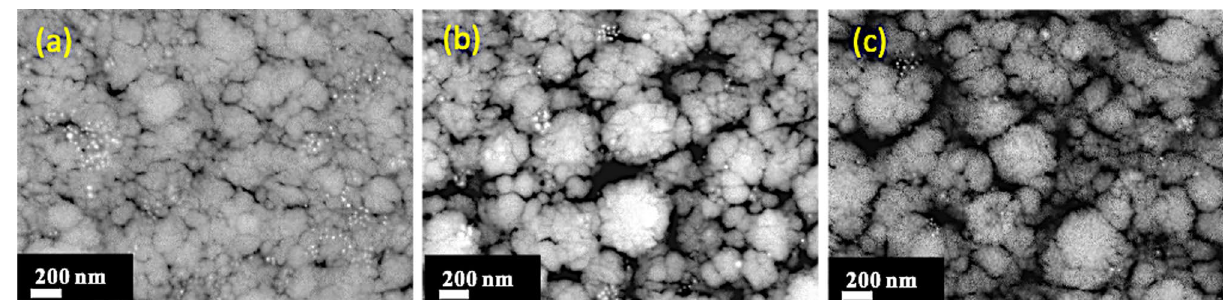
Figure 6. Backscattered electron micrographs of TiO 2 /Au-np nanocomposite films synthesized with increasing the matrix deposition rate via the current intensity applied on Ti targets (( a ) 2.0 A, ( b ) 2.5 A, and ( c ) 3.0